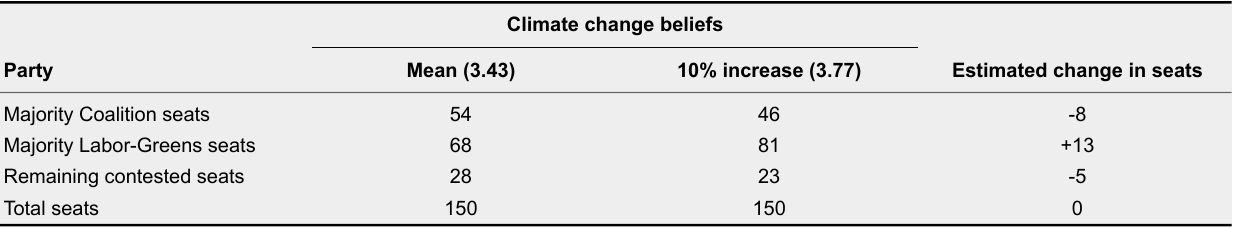
Estimated Majority and Contested Seats Under an Increase in Climate Change